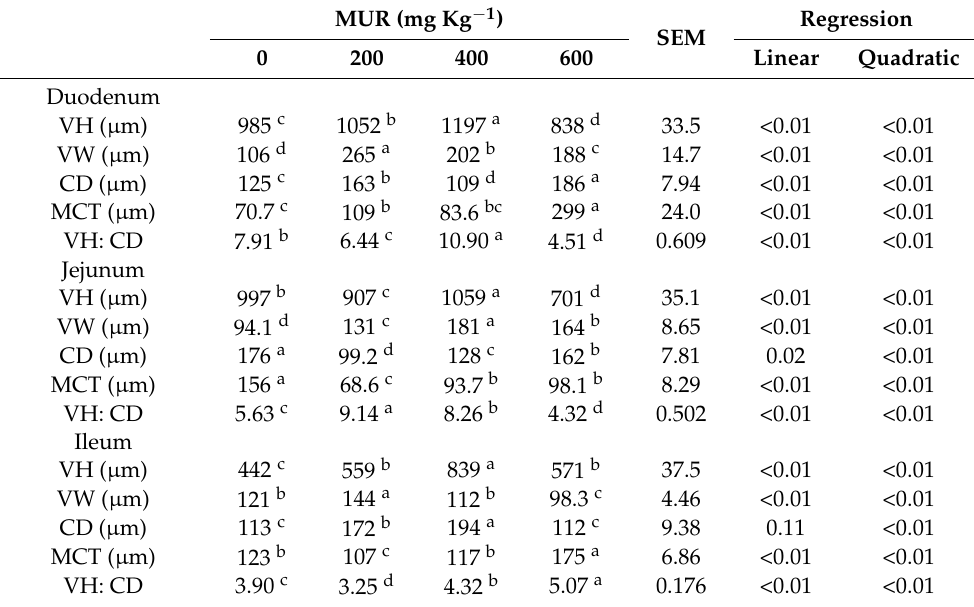
Table 6. The effect of MUR on the intestinal morphometric dimensions.